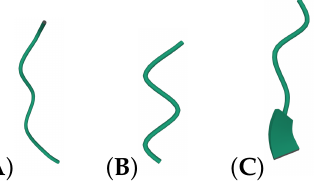
Figure 1. Examples of local writhe values on the SARS-CoV-2 Spike protein (PDB structure: 6ZGE): ( A ) residues 9–12: Wr = 0.0014, T = 0.2504; ( B ) residues 55–58: Wr = 0.11, T = 0.2499; ( C ) residues 59–62: Wr = − 0.00025, T = −